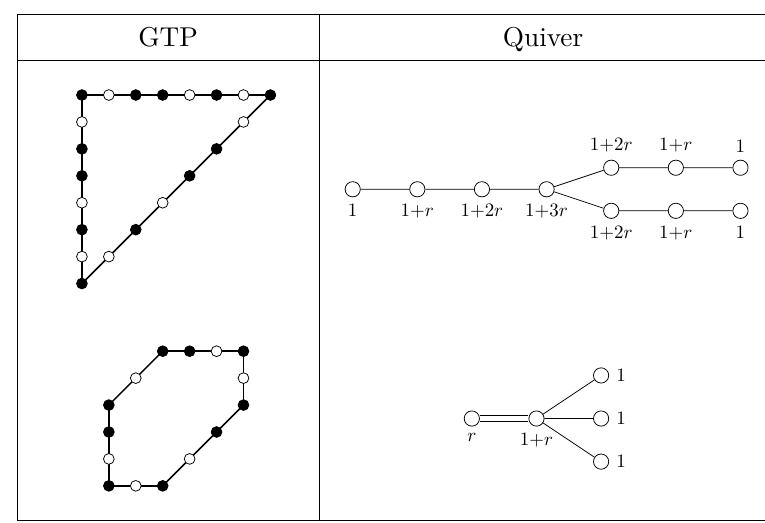
Table 10. Generalized toric polygons and magnetic quivers for the 5d theories corresponding to ‘ = 3 . Top for s = 1 , bottom for s = 2 . The GTPs are drawn for r = 2 , in order to match with the brane web